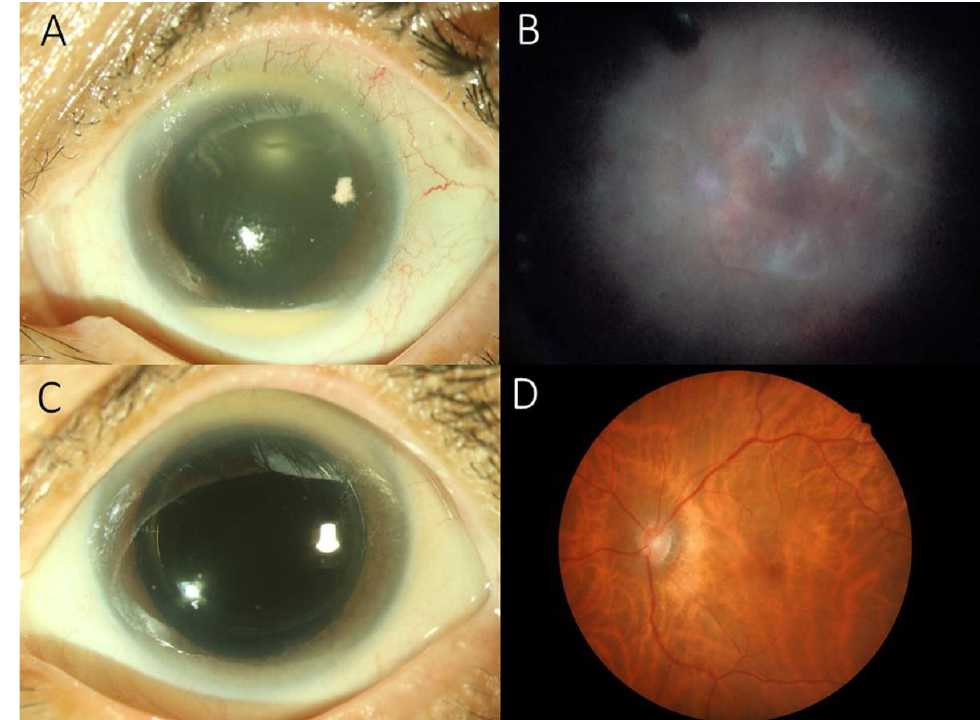
Figure 1. ( A ) Slit-lamp biomicroscopic examination showing corneal edema with a 2-mm hypopyon in patient 4. ( B ) During pars plana vitrectomy, posterior pole showing diffuse retinal vasculitis. ( C ) Four weeks later, Slit-lamp biomicroscopic examination showing clear cornea without hypopyon. ( D ) Fundoscopic examination revealing myopic tessellated retina with resolution of retinal vasculitis. Antibiotic Susceptibility Testing